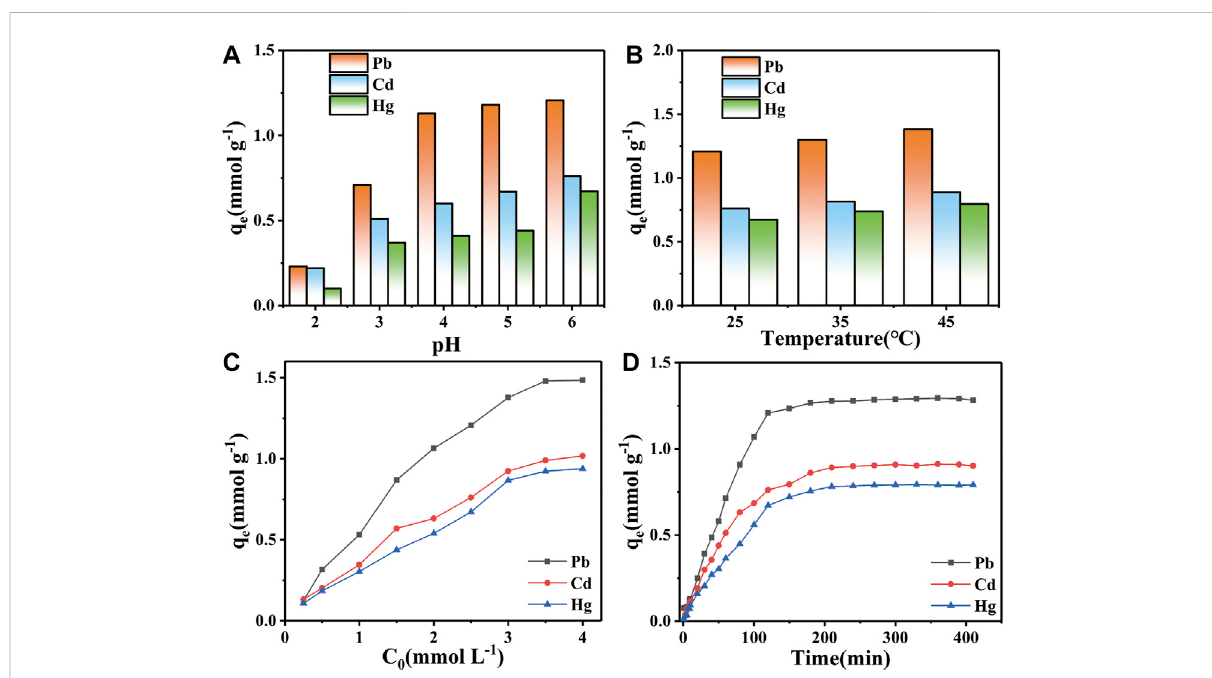
FIGURE 7 Effect of (A) pH value, (B) temperature, (C) adsorption time and (D) initial concentration on Pb 2+ , Cd 2+ and Hg 2+ ions